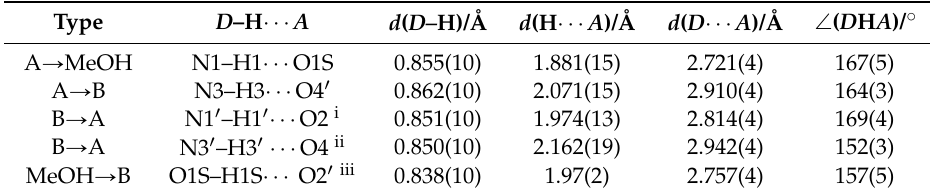
Table 2. Geometric parameters for hydrogen bonds in 1MH